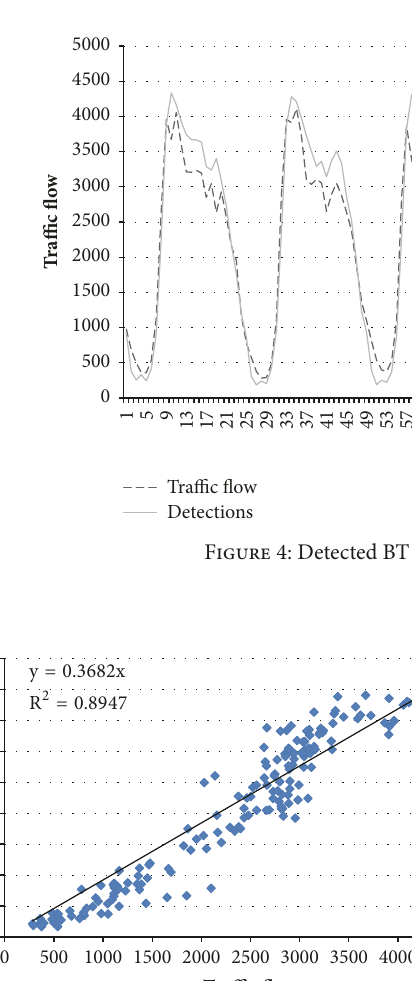
applied, since the sample is “controlled” (all the data is related to